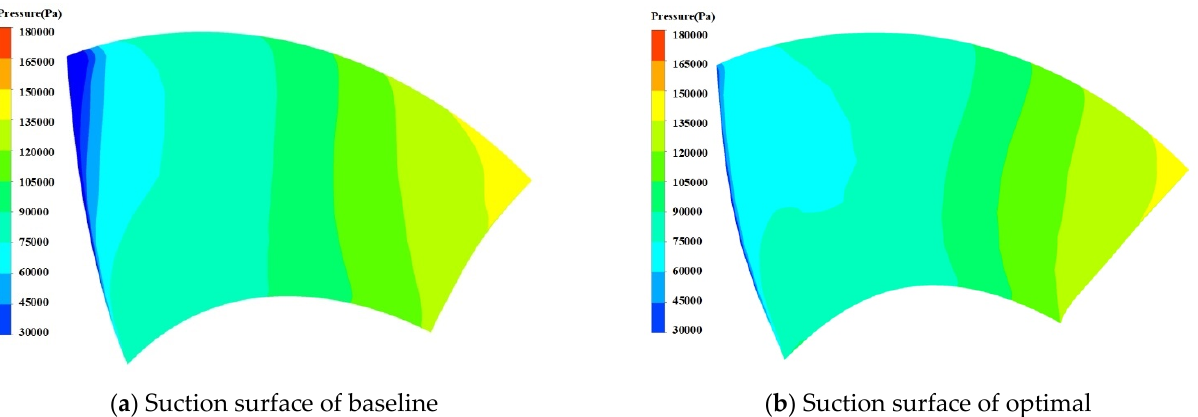
Figure 11. Pressure distributions on blade for baseline pump and optimal pump.